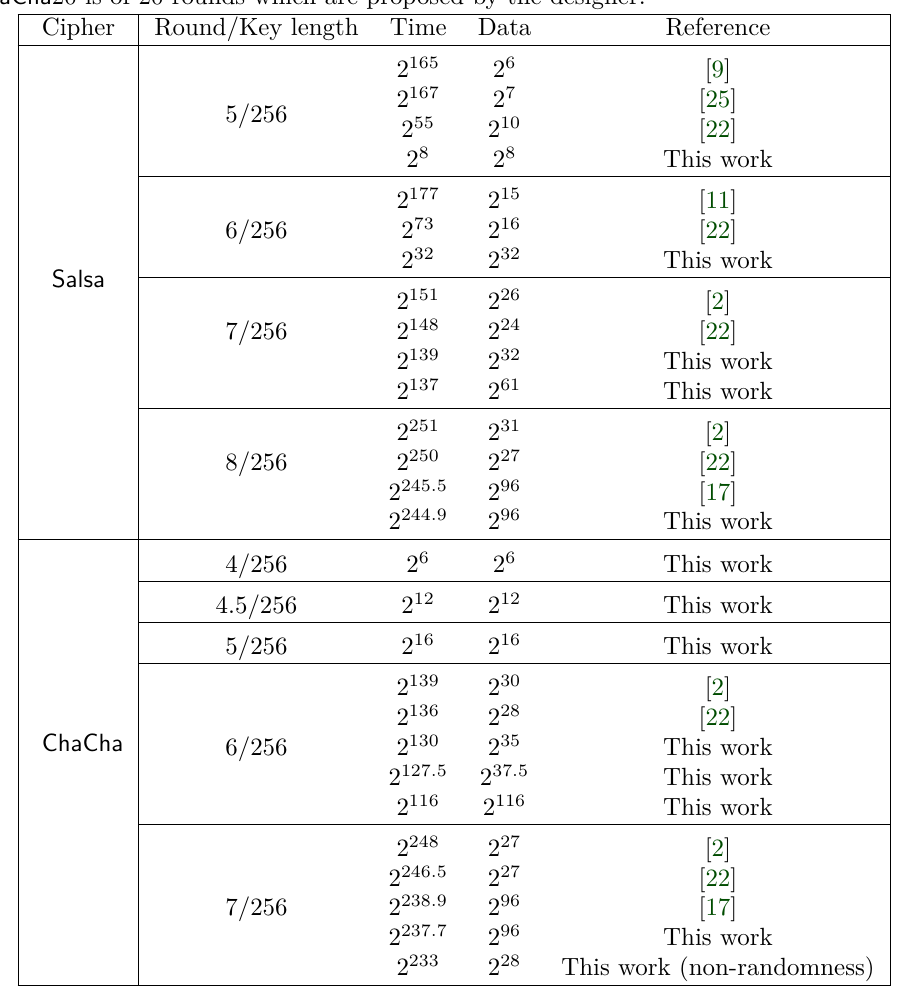
Table 1: Complexity of the attacks for different rounds in the reduced-round versions. The last row indicates result related to non-randomness. Salsa 20/12 is of 12 rounds and ChaCha 20 is of 20 rounds which are proposed by the